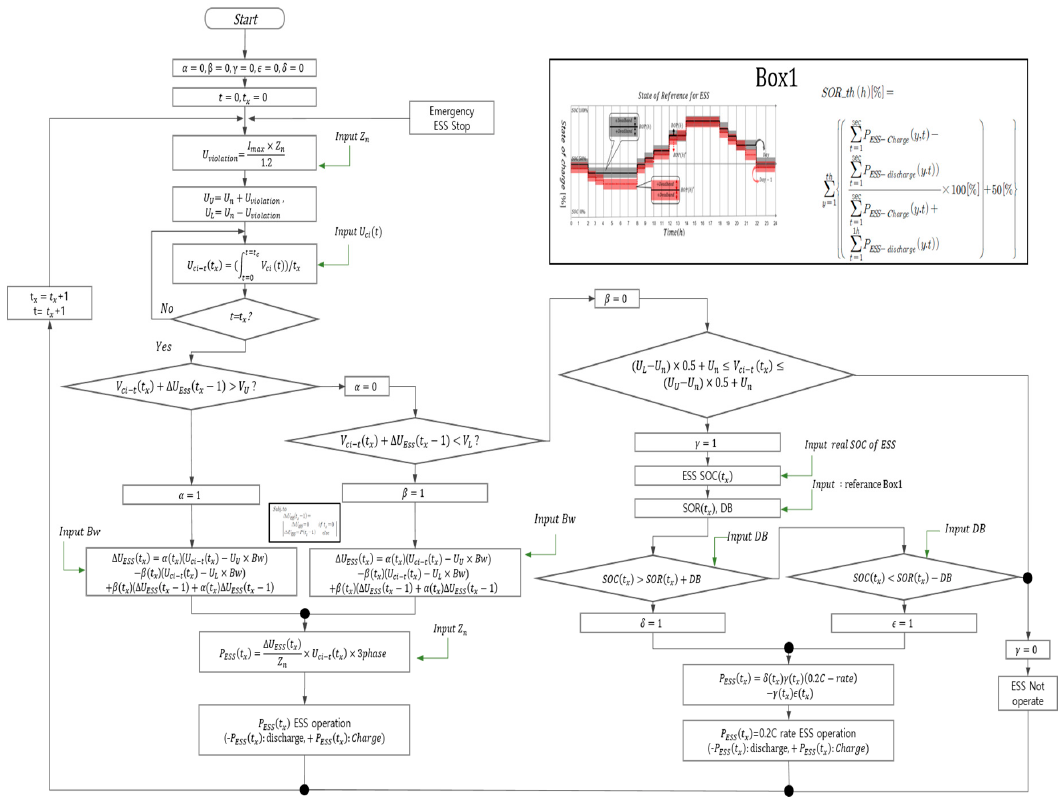
Figure 12. Flowchart of coordination control strategy between EVI-algorithm and SOR-algorithm for ESS.